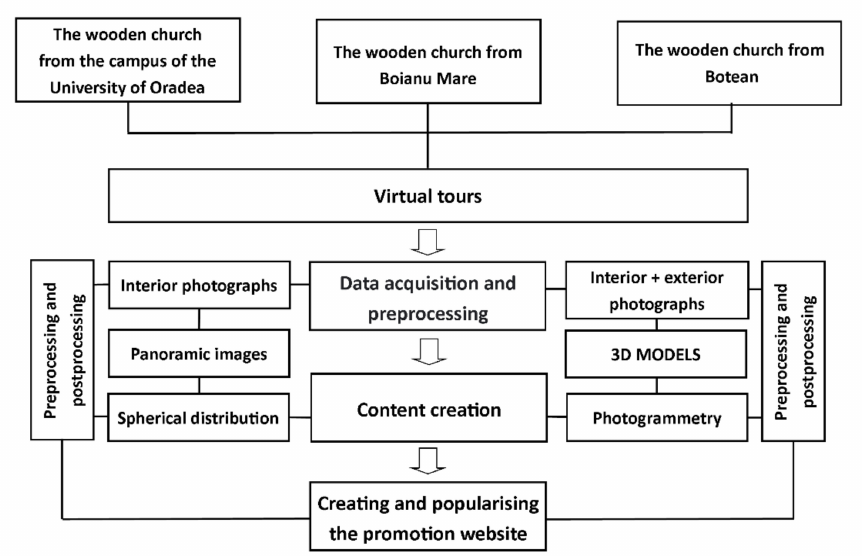
Figure 2. Schematic diagram of the main methodological